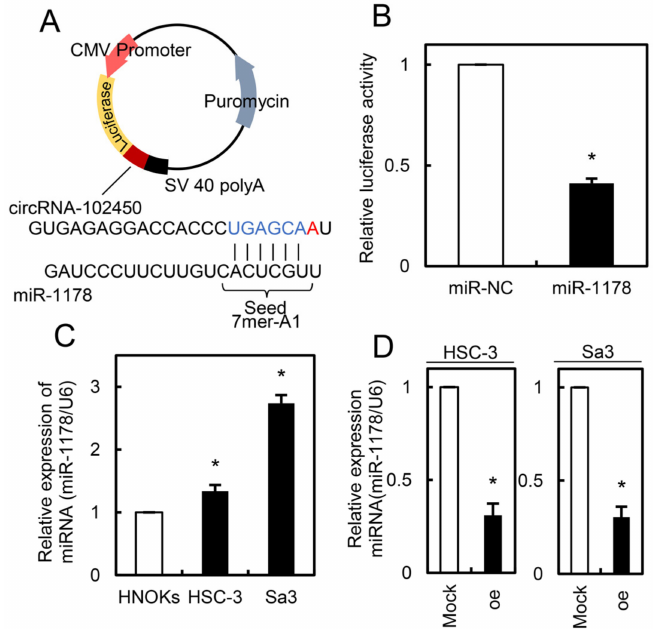
Figure 7. Expression of miR-1178 as a target of circRNA-102450. ( A ) Schematic illustration of the miR-1178 binding site in the circRNA-102450 sequence, inserted into a luciferase reporter vector. ( B ) Luciferase reporter assays showing that transfection of miR-1178 inhibited luciferase activity compared with transfection of the negative control miRNA. Data are expressed as means ± SD (* p < 0.05). ( C ) Up-regulation of miR-1178 in OSCC cells (HSC-3 and Sa3) compared with HNOKs. Data are expressed as means ± SD (* p < 0.05). ( D ) Down-regulation of miR-1178 in oe-circRNA- 102450 cells compared with the Mock cells. Data are expressed as means ± SD (* p < 0.05). oe, oe-circRNA-102450